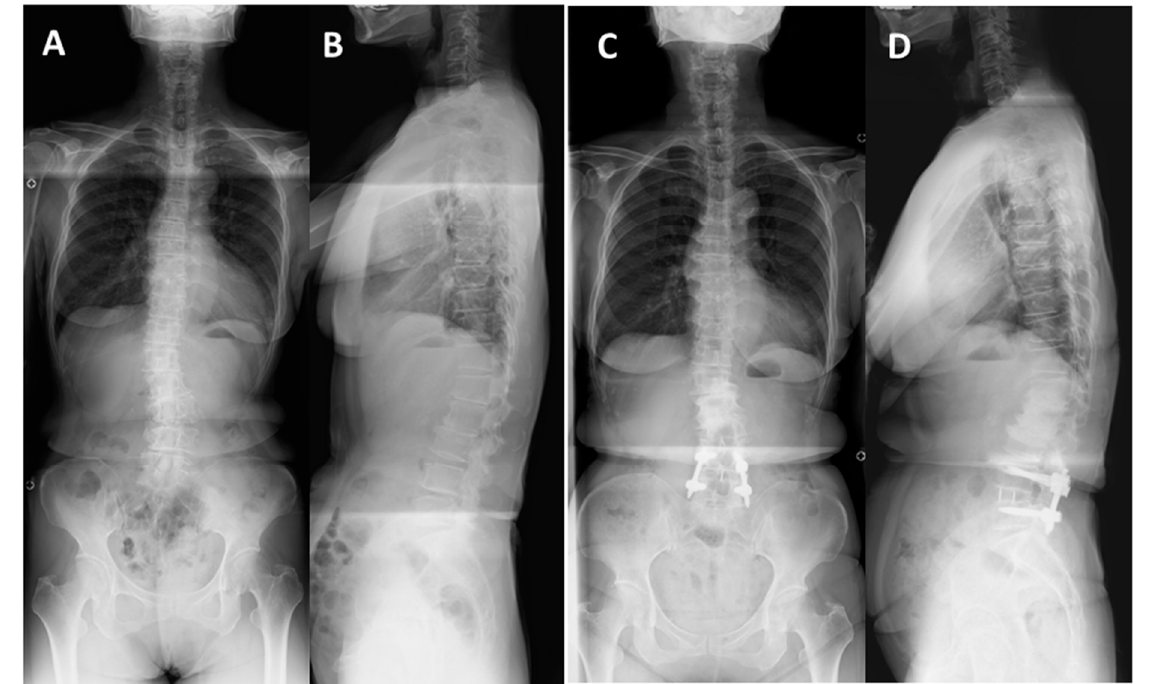
Figure 5. Seventy-two-year-old woman with lumbar degenerative scoliosis and multiply operated back: ( A , B ) Preoperative standing radiographs showing lumbar degenerative scoliosis. ( C , D ) Stand- ing radiographs 5 year after surgery showed successful bony fusion and no correction loss at the L4/5 level that underwent LLIF. There were increased degenerative changes in the upper and middle lumbar spine, but no residual symptoms.